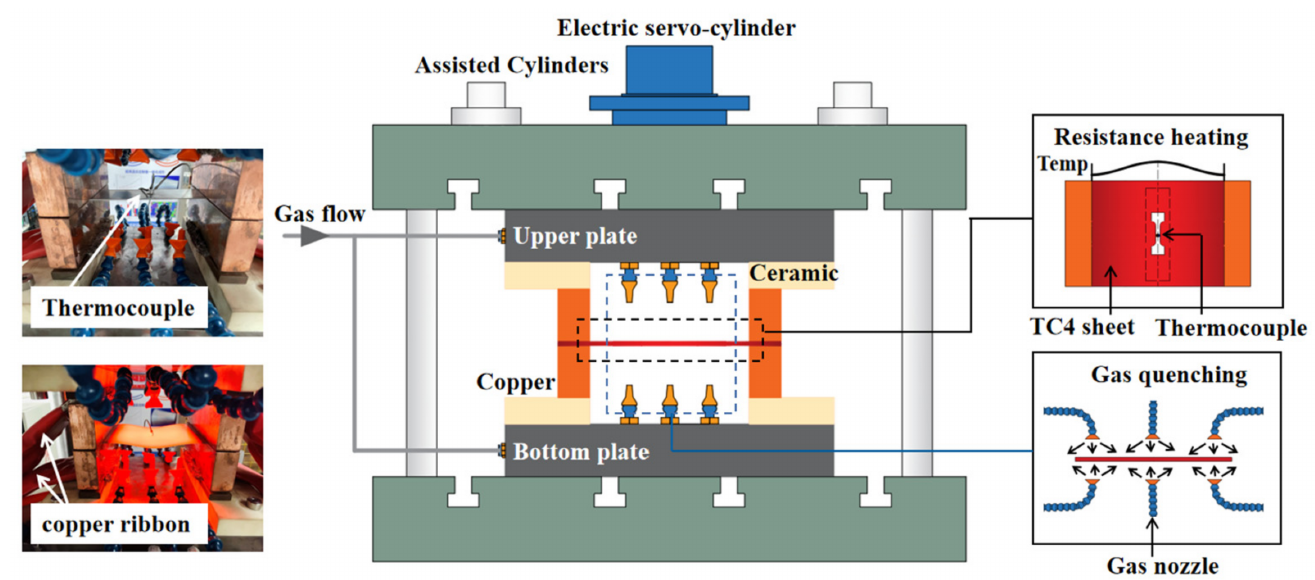
Figure 3. Schematic diagram of the resistance heat treatment